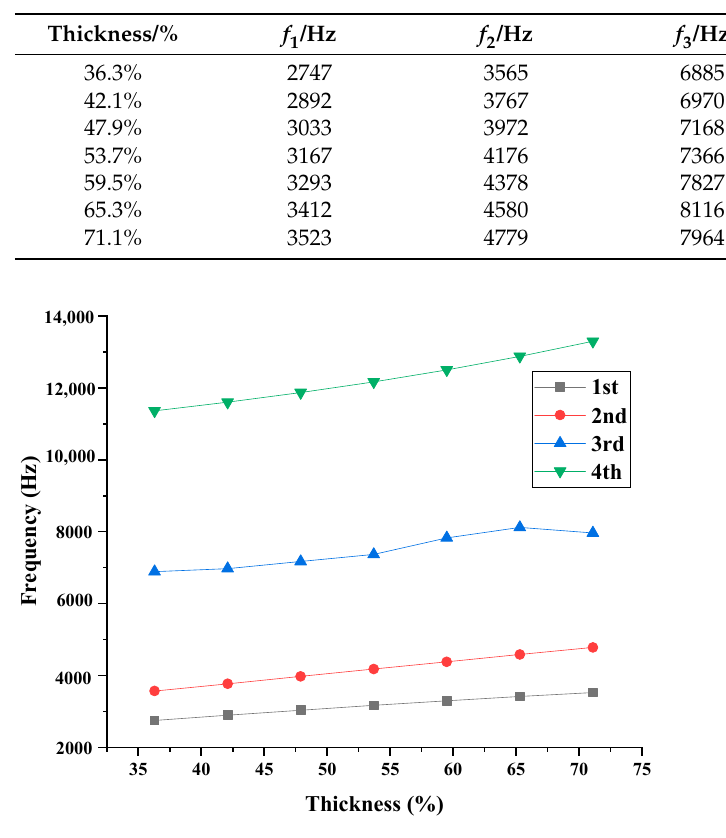
Figure 15. TWR characteristics of gears with different vibration mode at different thickness of spoke plate.